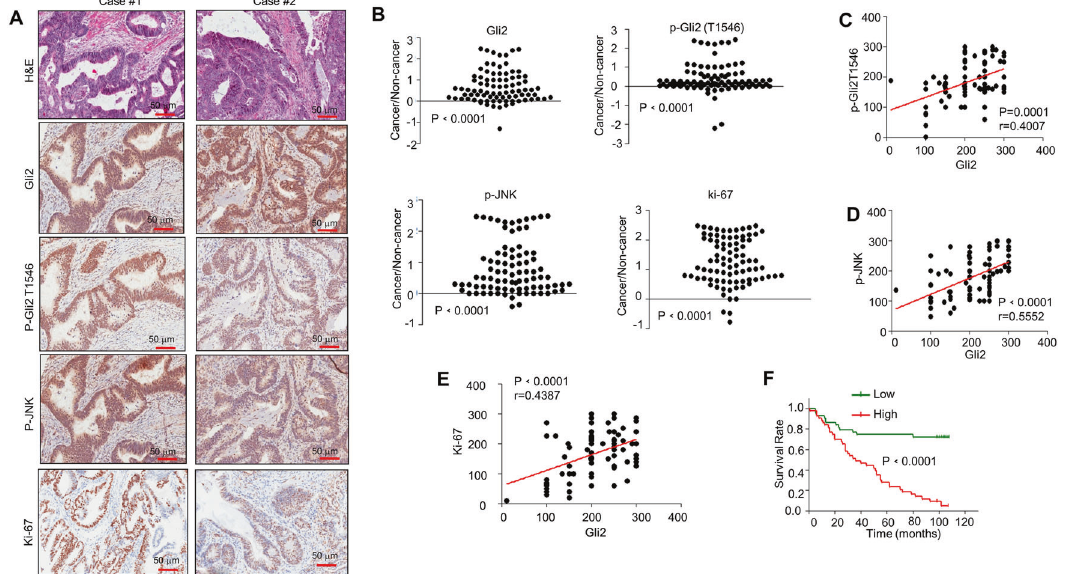
Fig. 6 Phosphorylated JNK and Gli2T1546 are correlated with Gli2 expression in colorectal cancer. A H&E staining and IHC staining of the primary human CRC tissue microarray. Scale bar, 50 μ m. B Scatter plot showing the Gli2, p-Gli2T1546, p-JNK, and ki-67 staining level in individual tumors as a ratio of staining in CRC versus paired non-cancer tissue. n = 86. C Correlation plot of p-Gli2T1546 and Gli2 IHC staining (arbitrary units). Correlation was evaluated by nonparametric Spearman test. The coef fi cient of correlation ( r ), and the p value ( p ) are indicated. n = 86. D Correlation plot of p-JNK and Gli2 IHC staining (arbitrary units). Correlation was evaluated by nonparametric Spearman test. The coef fi cient of correlation ( r ), and the p value ( p ) are indicated. n = 86. E Correlation plot of ki-67 and Gli2 IHC staining (arbitrary units). Correlation was evaluated by nonparametric Spearman test. The coef fi cient of correlation ( r ), and the p value ( p ) are indicated. n = 86. F Kaplan – Meier survival analysis of CRC cases separated into two groups by the median value for phospho-Gli2 T1546 staining. The p value was calculated by log rank